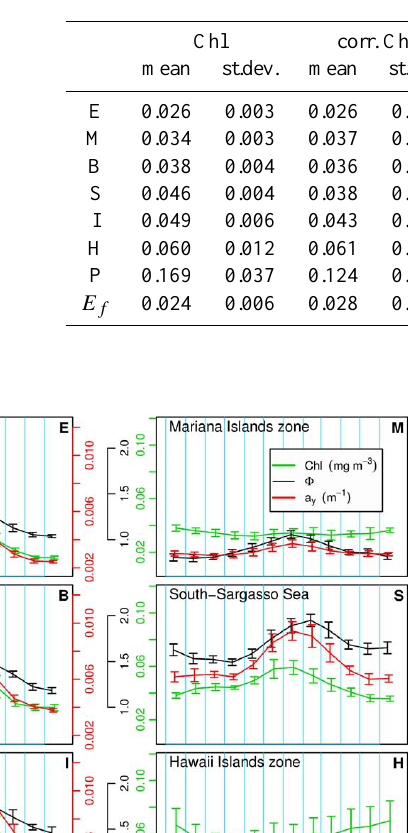
Table 2. Annual mean values over the ten years (1998–2007) period of the quantities [Chl] (mgm − 3 ) , 8 (dimensionless), and a y (443) (m − 1 ) , for each zone, including “P” (Portugal) and “ E f ” (the sub-zone in the E zone). The (12) average monthly values of the same quantities for each zone, as displayed on Fig. 3, are used to obtain the annual mean values. The pooled standard deviations are simply the average of the standard deviations pertinent to each month (those shown in Fig. 3).